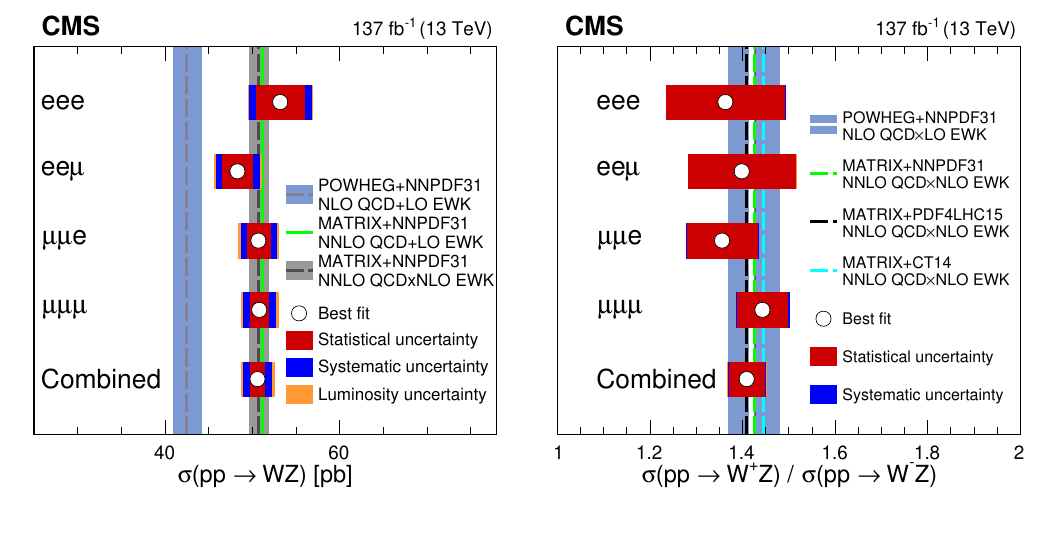
Figure 7 . Total WZ production cross section (left) and charge asymmetry ratio (right) for each of the flavour-exclusive and flavour-inclusive categories. The shaded vertical bands show the the- oretical predictions from powheg (light blue) and matrix (grey). For each of the measurements, the best fit value is denoted with a white point and three main groups of uncertainties (statistical, systematic and luminosity) are denoted as differently coloured (red, blue, and orange) bands with each one being added quadratically on top of the previous one. For the charge asymmetry ratio both powheg and matrix predictions are close to exact agreement, leading to the blue and grey lines to overlap in the plot. Predictions obtained using matrix and several central replicas of different PDF sets are also shown as individual lines in the